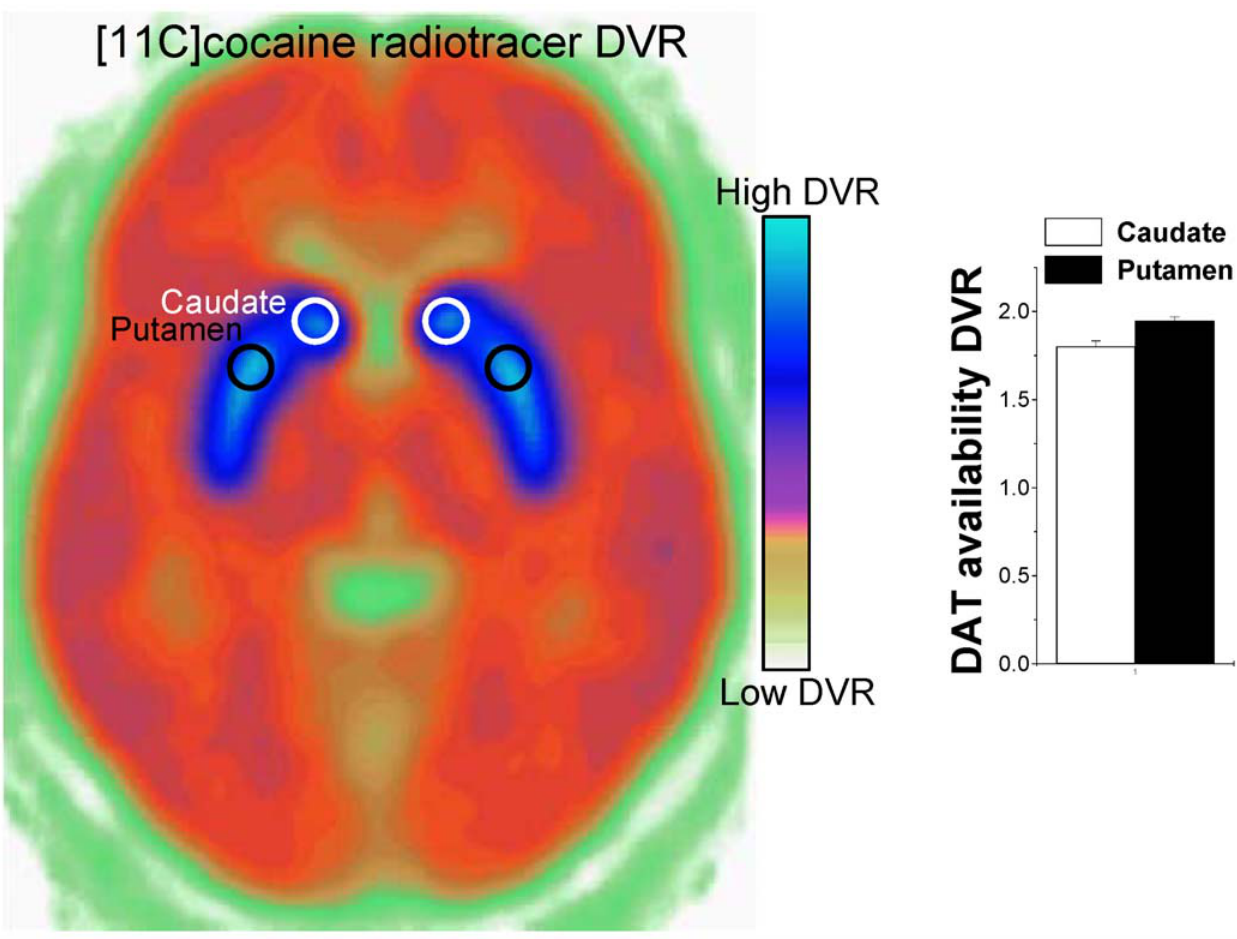
Figure 1. Dopamine transporter (DAT) distribution. Averaged DVR [ 11 C]cocaine image at the level of the striatum and ROI measures of DAT availability in caudate and putamen. Values represent means 6 standard deviations across 14 healthy men.